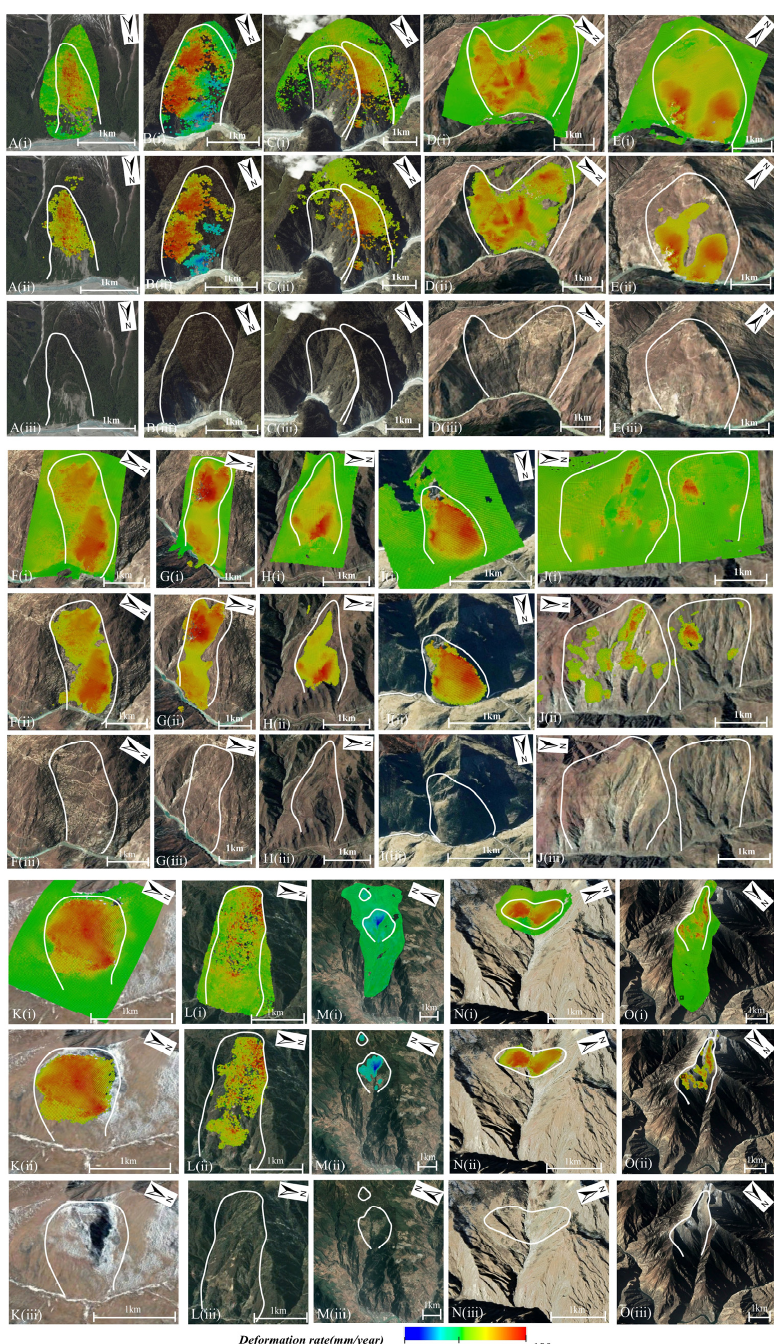
Figure 7. Enlarged results of typical landslides. ( A – O ) are landslide numbers shown in Figure 6; (i) Original deformation rate map. (ii) Effective deformation data extracted by hot spot analysis. (iii) Google optical image. Specific locations of each landslide are shown in Figure 6.